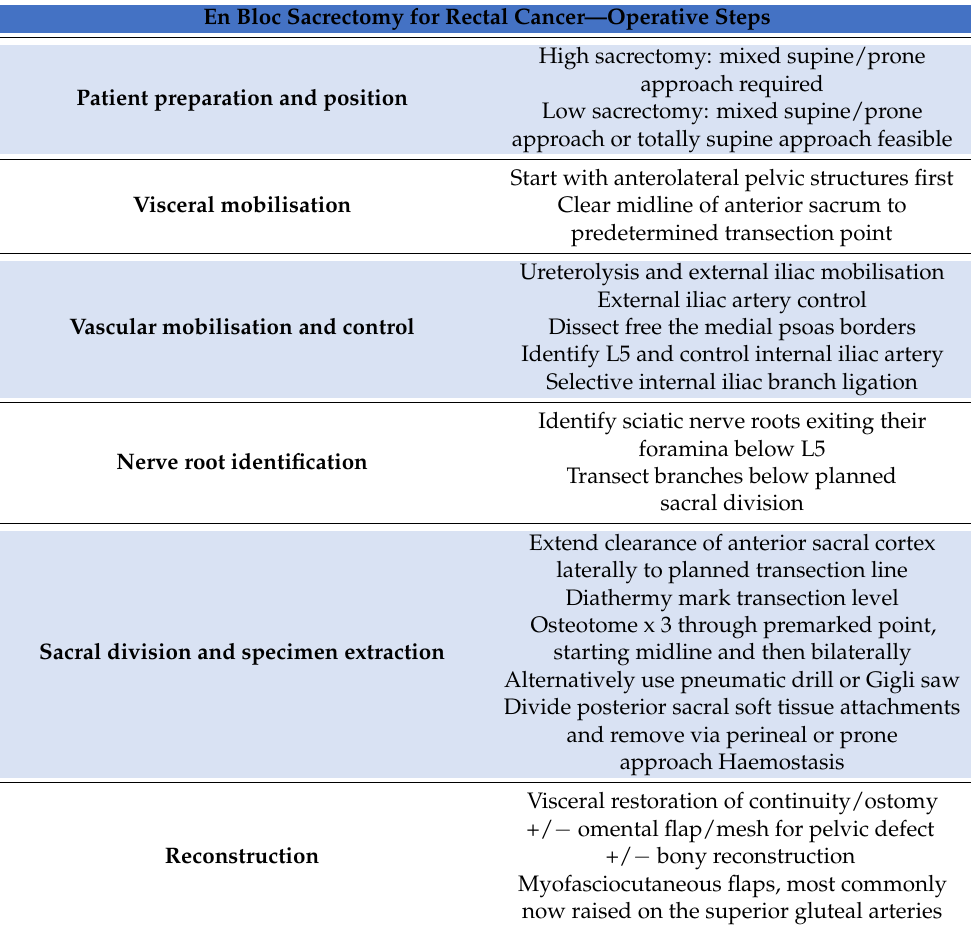
Table 1. Operative steps of en bloc sacral resection. Overview of surgical manoeuvres involved in high and low